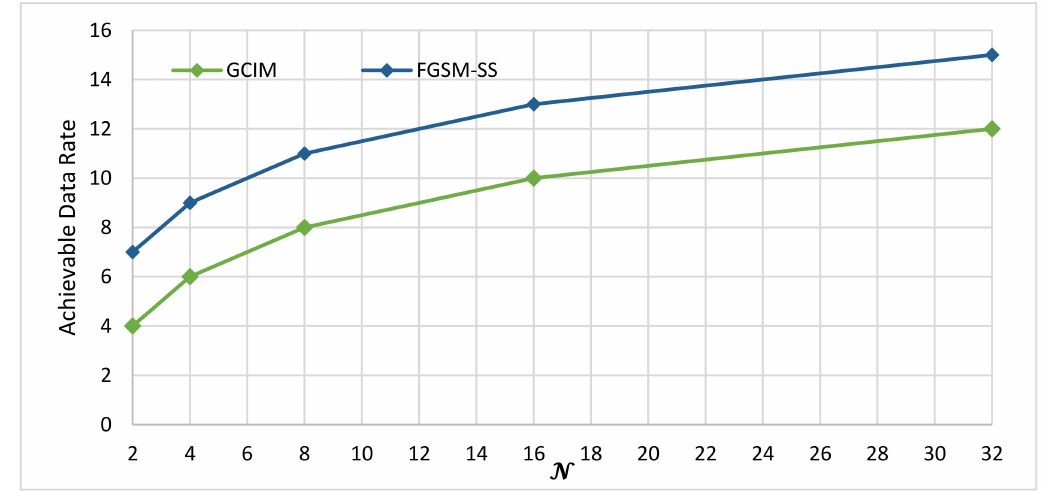
Figure 3. The maximum achievable data rates of GCIM and proposed DLSS-FGSM under di ff erent code length N